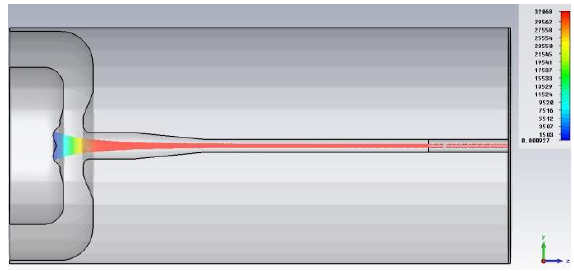
Fig. 1. Electron gun geometry and particles trajectories simulated by CST Studio code